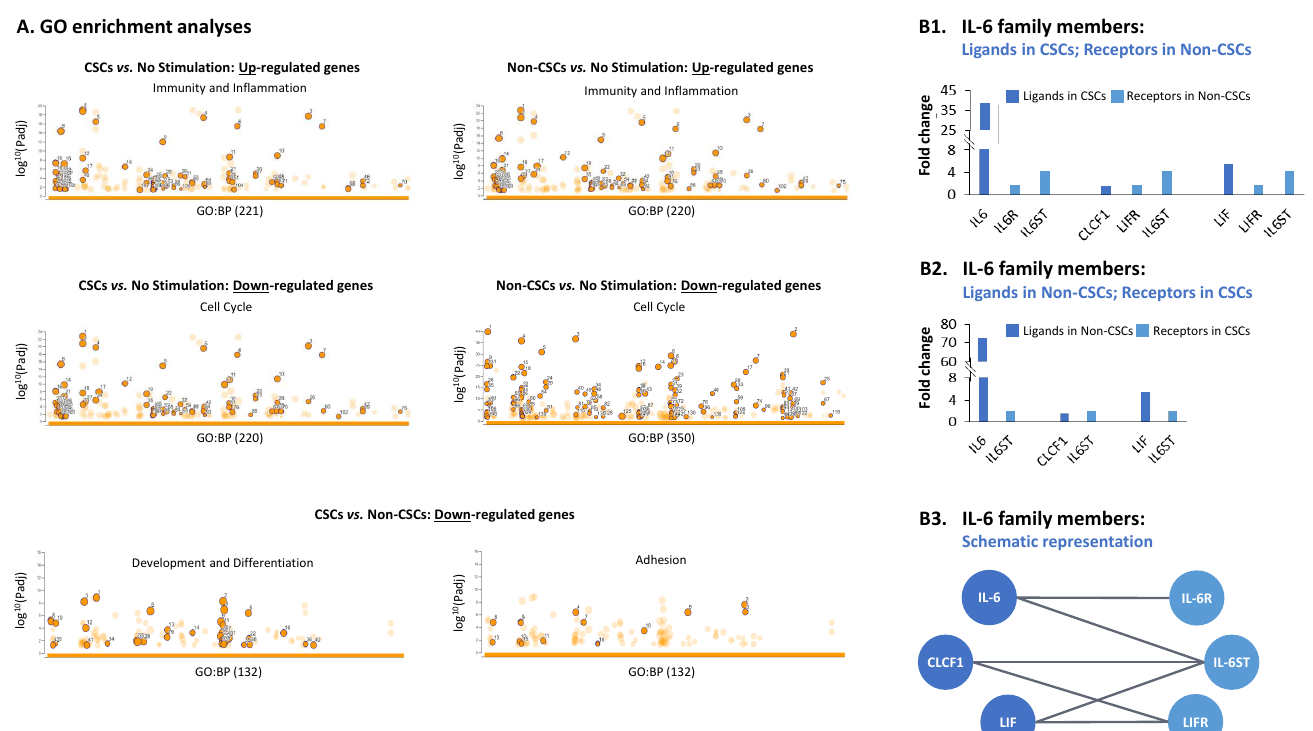
Figure 3. Differences in gene expression induced by TME Stimulation in CSCs and Non-CSCs, and expression profiles of IL-6 family members in HR+/HER2 − breast cancer cells: The